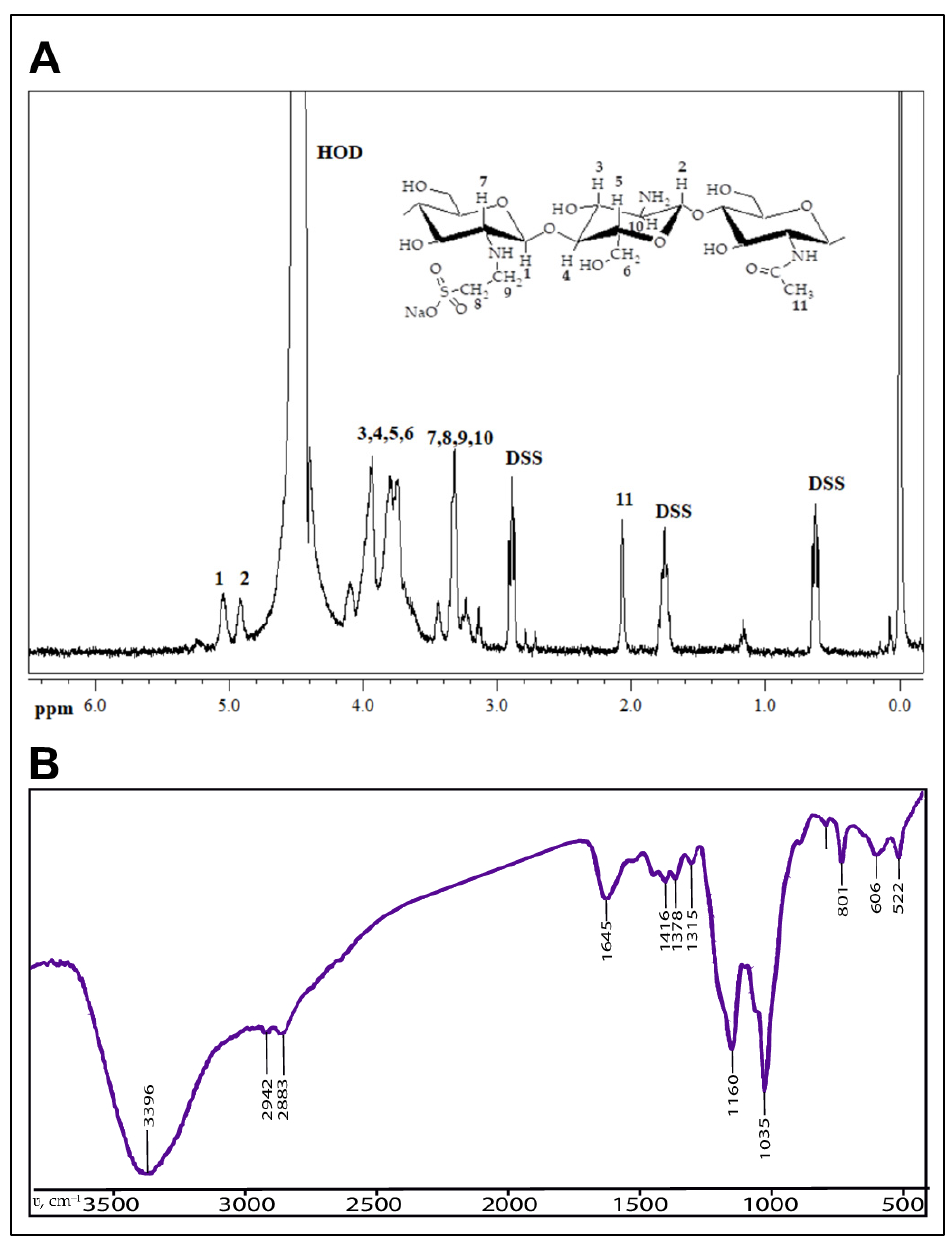
Figure 3. ( A ). The structural units and the 400 MHz 1 H NMR spectrum of sodium ( A ). The structural units and the 400 MHz 1 H NMR spectrum of sodium N-(2- N-(2-sulfonatoethyl)chitosan with degrees of substitution 1.0 (D 2 O/DCl) (DSS– sulfonatoethyl)chitosan with degrees of substitution 1.0 (D 2 O/DCl) (DSS–2,2-dimethyl-2-silapentane- 2,2-dimethyl-2-silapentane-5-sulfonate sodium salt was used as an internal 1 H NMR standard; 5-sulfonate sodium salt was used as an internal 1 H NMR standard; ppm—parts per million); ( B ). ppm—parts per million); ( B ). FT-IR spectrum of crosslinked N-(2-sulfoethyl)chitosan with glutar- aldehyde.